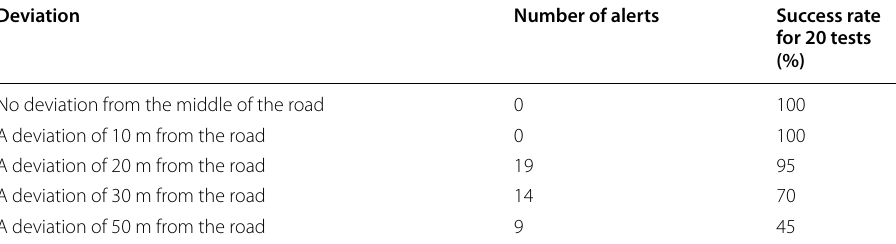
Table 1 Percentage success rates for the application’s response to deviation from the middle of a